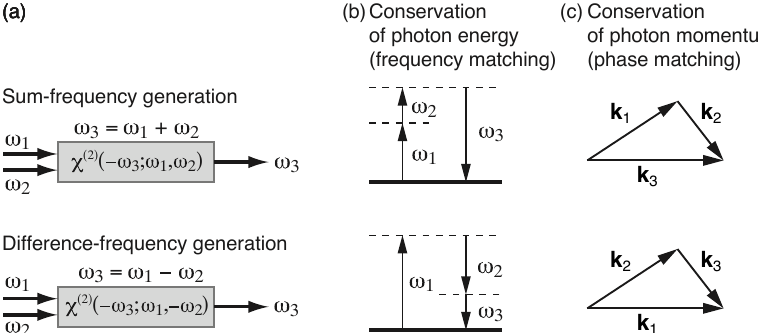
Figure 2. ( a ) schematics of the two basic parametric second-order NLO processes: sum-frequency generation and difference-frequency generation with ( b ) the corresponding energy-level diagram and ( c ) wavevectors k i that satisfy the phase-matching